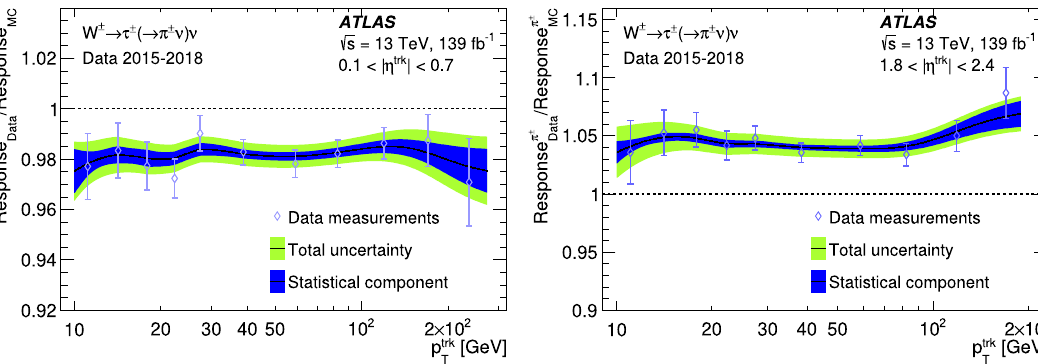
statistical and systematic sources. Also shown is the smooth calibration curve with its associated